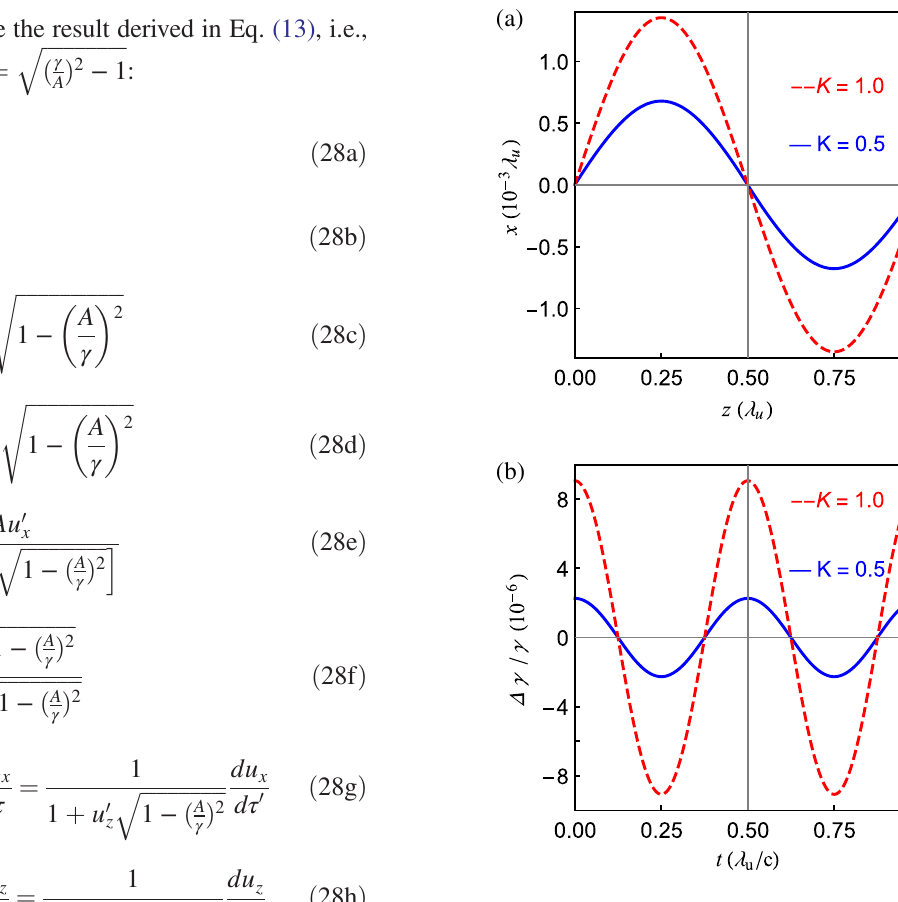
FIG. 2. Trajectory and energy modulation in the lab frame. (a) A period of electron trajectory. (b) Normalized change in the energy of the electron during a single